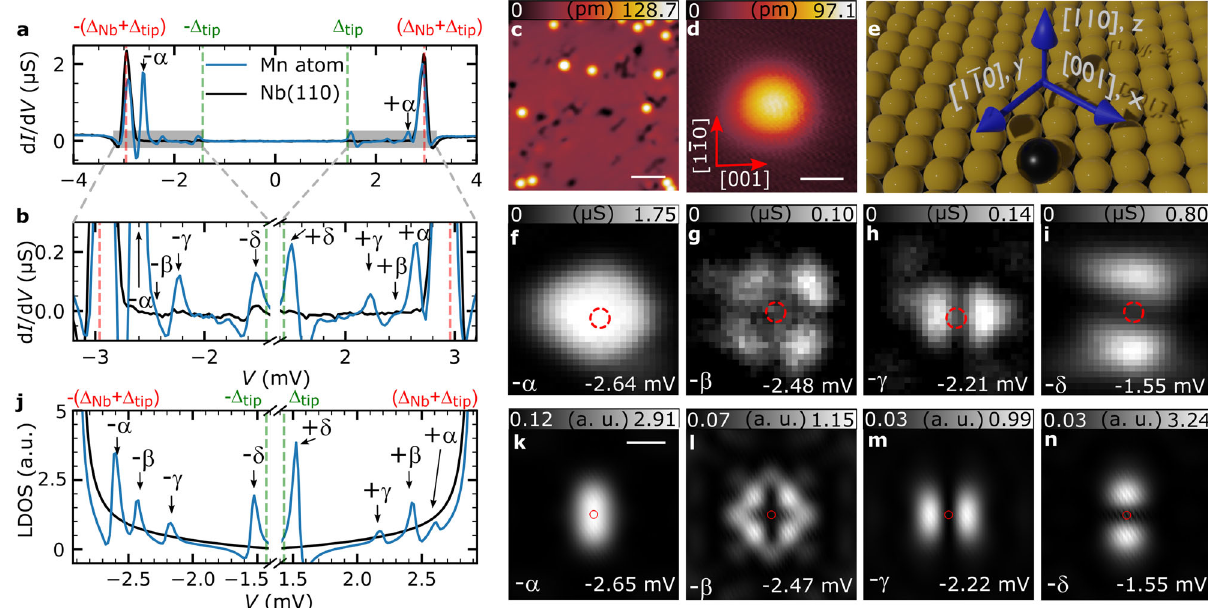
Fig. 1 Shiba states of single Mn adatoms on Nb(110). a d I /d V spectra obtained on bare Nb(110) (black) and over a Mn adatom (blue). Red and green vertical lines mark the positions of the coherence peaks ±( Δ Nb + Δ tip ) and the tip gap Δ tip , respectively. b Magni fi cation of the spectra shown in panel a . The coherence peaks and the two peaks with the largest intensity are left out for the sake of visibility. Shiba states are labeled and marked by arrows. c Overview STM image of the Mn/Nb(110) sample, where bright protrusions are single Mn adatoms and black depressions correspond to residual oxygen. The white scale bar has a length of 3 nm. ( V bias = 100 mV and I = 200 pA). d STM image of a single Mn adatom, which was used for recording the spectra in a and b , as well as for the d I /d V maps in f – i . The white scale bar has a length of 500 pm and the red arrows point along two high symmetry directions (cid:1) (cid:3) 1 (cid:1) 10 and [001] of the Nb(110) surface. The directions also apply to panels f – i and k – n . e 3D rendered illustration of the position of the single Mn adatom (black sphere) with respect to the Nb substrate atoms (yellow spheres), including the high-symmetry directions indicated by blue arrows with their nomenclature. f – i d I /d V maps measured at the given bias voltages of the Shiba states marked in a and b and in the area of d in the vicinity of the single Mn adatom. The d I /d V maps taken at the Shiba peaks on the positive bias side are shown in Supplementary Fig. 5. j Calculated LDOS inside the superconducting gap convoluted with the DOS of the superconducting tip ( ± Δ tip ¼ 1 : 43 mV) at the position of the Mn adatom (blue) and on the bare superconductor (black). k – n Calculated two-dimensional maps of the LDOS at the bias voltages indicated in the fi gures. The white scale bar has a length of 500 pm. Red circles in f – i and k – n highlight the position of the